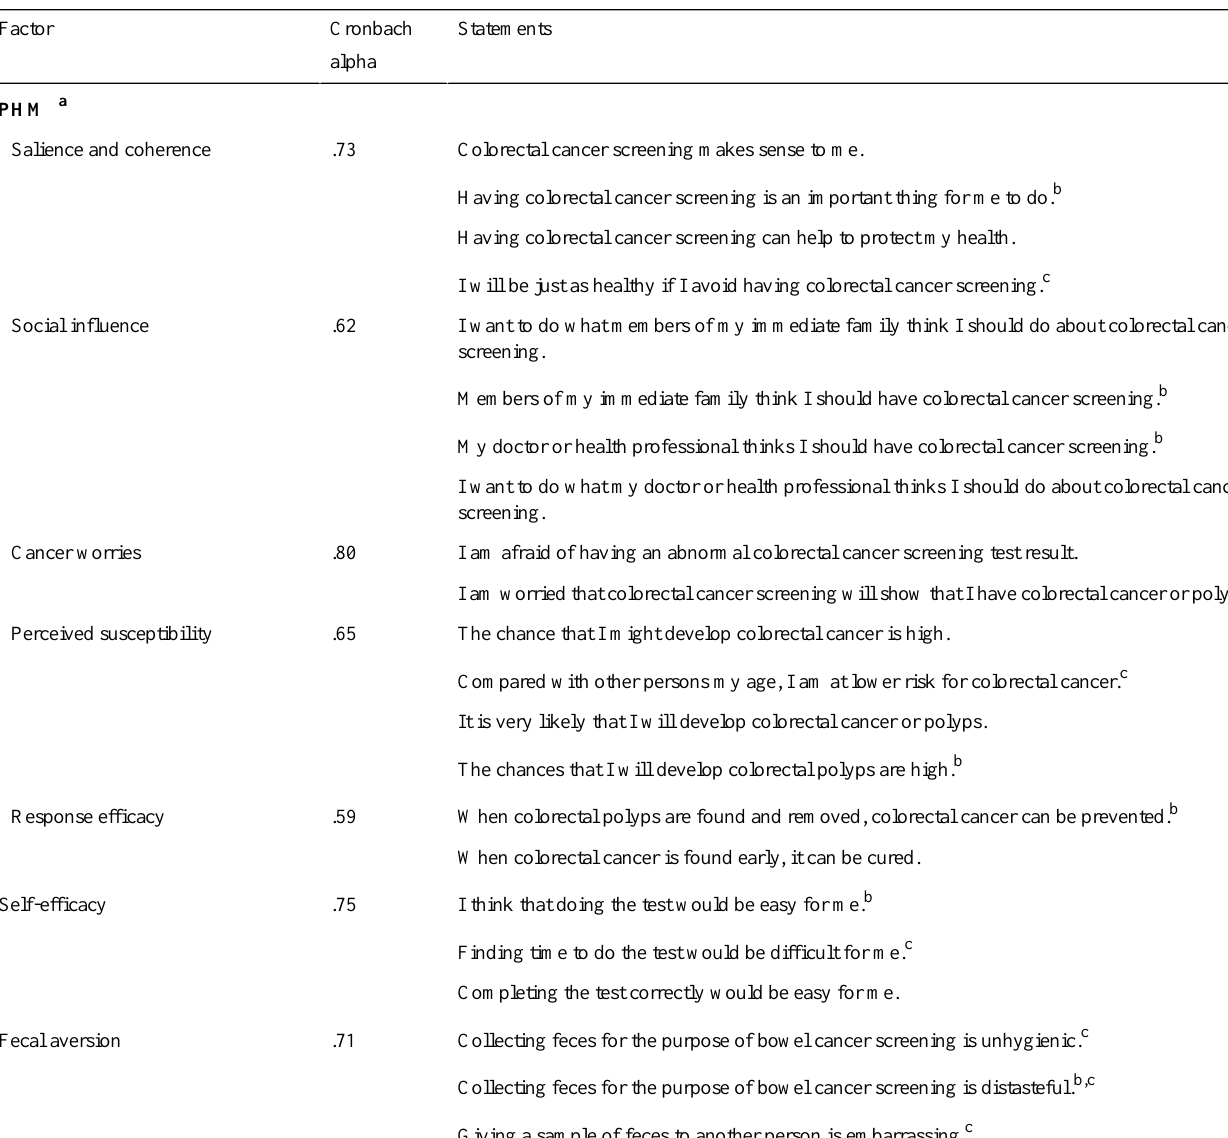
StatementsCronbach